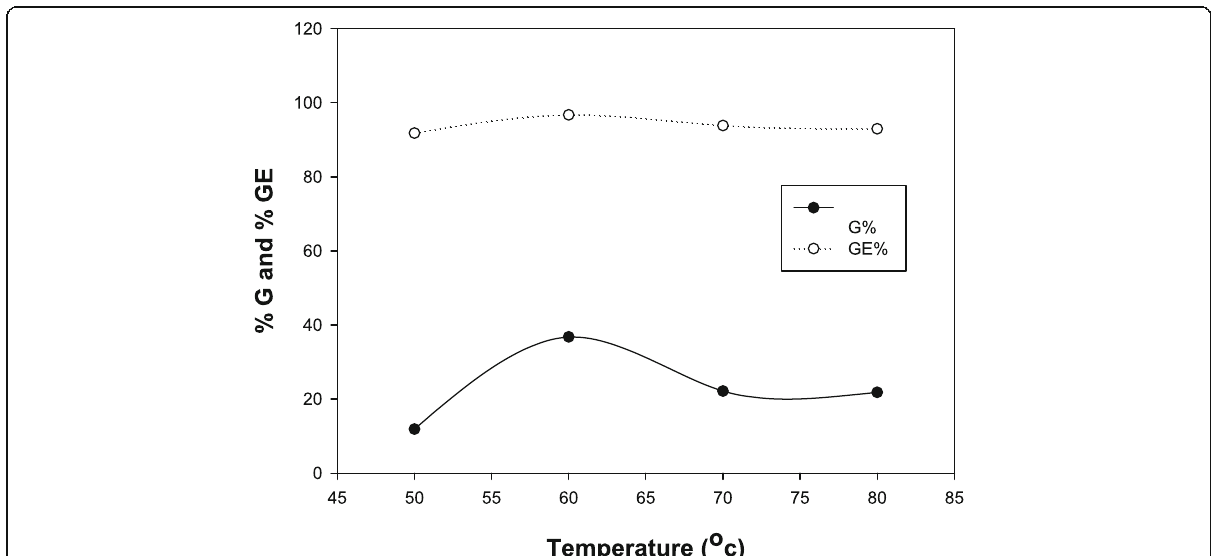
Fig. 3 Effect of reaction temperature on grafting percentage (%G) and grafting efficiency (%GE) (Reaction conditions: 1 g CMCh, 3 M styrene, time 2 h, [APA]=0.6